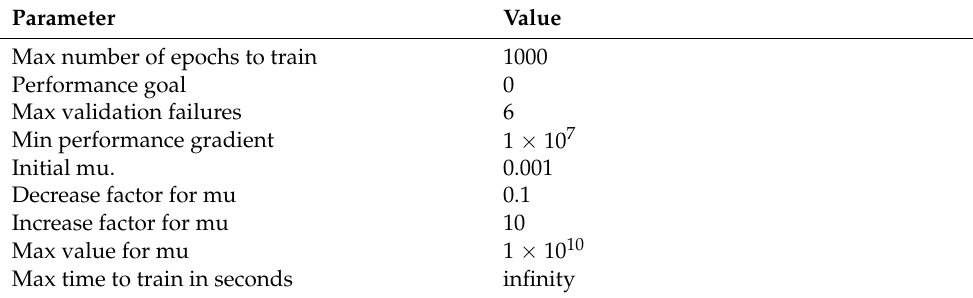
Table 3. Proposed DLSA prediction model for setting